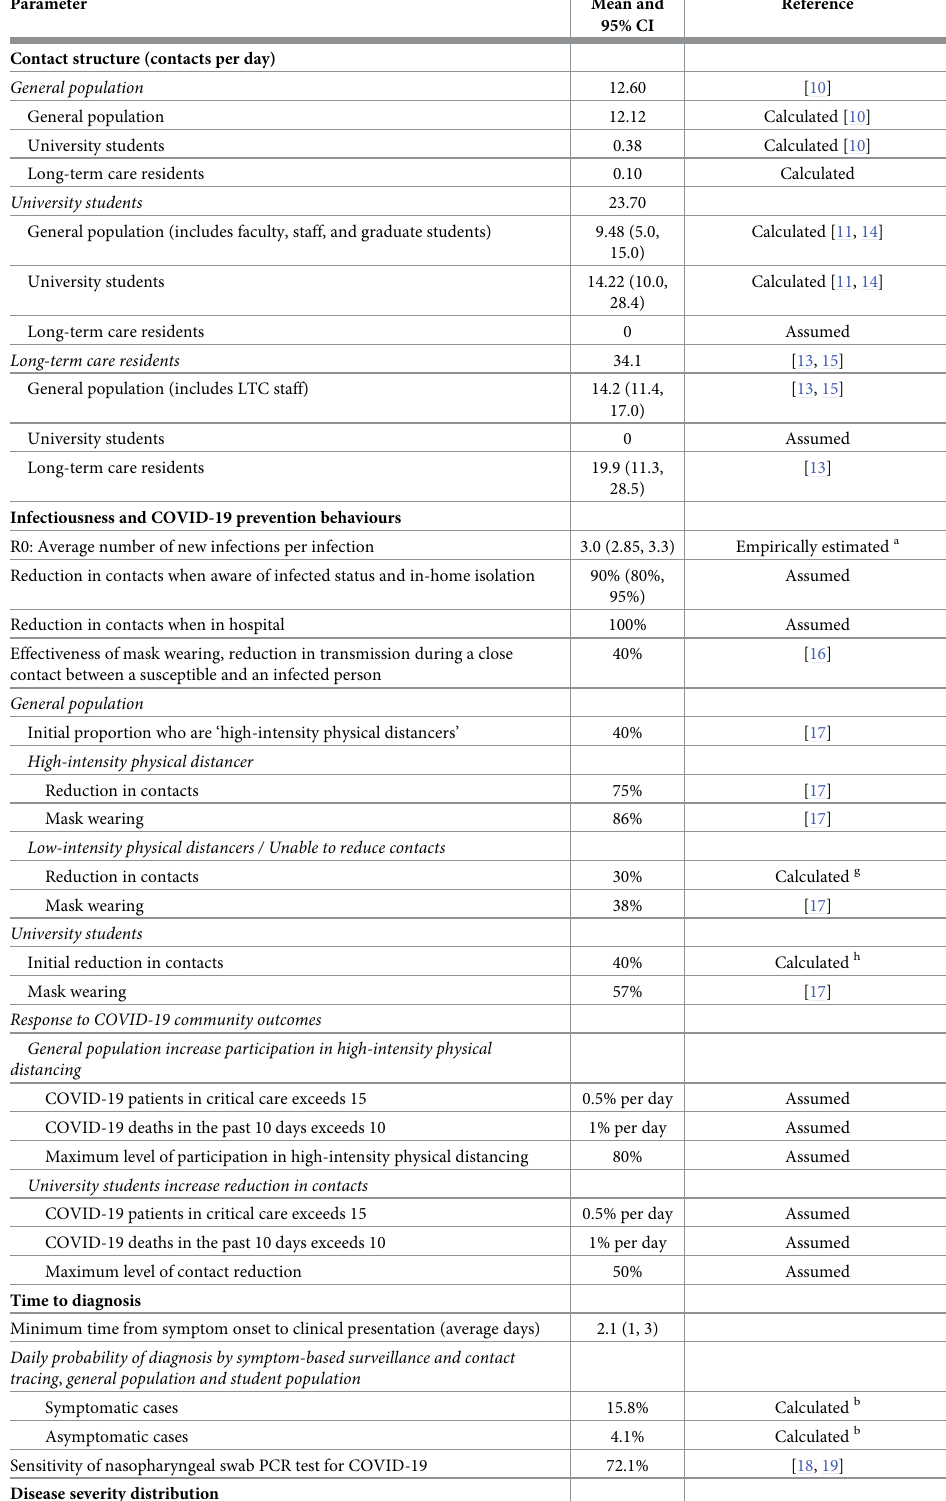
Table 1. Base case parameters and